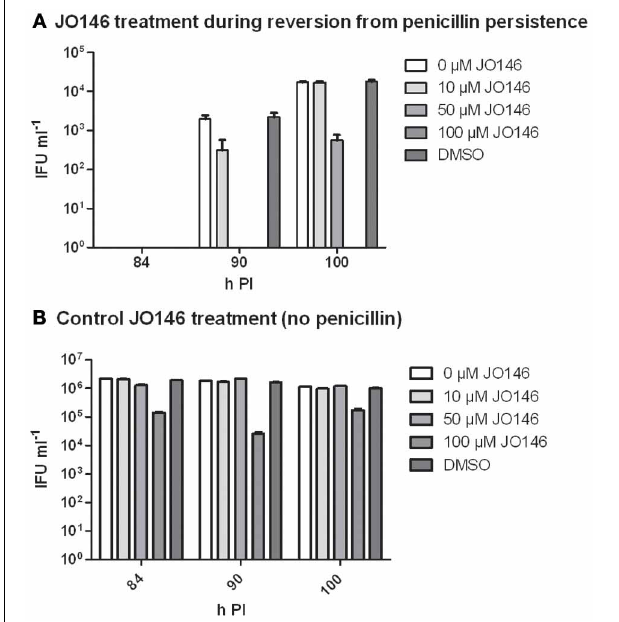
FIGURE 7 | Viable infectious yield when JO146 was added during the reversion from penicillin persistence. Cultures were treated with penicillin 100U ml − 1 at 4h PI. Penicillin was removed at 40h PI and JO146 treatment was commenced at 52h PI. (A) JO146 was added 12h after penicillin persistence reversion was commenced (i.e., at 52h PI). (B) Control cultures that were not persistent with JO146 treatment also conducted at 52h PI. The graphs show the viable infectious yield at several time points after reversion from persistence was commenced ( n = 27). JO146 concentration is indicated by the gray shading (legend to the right of each